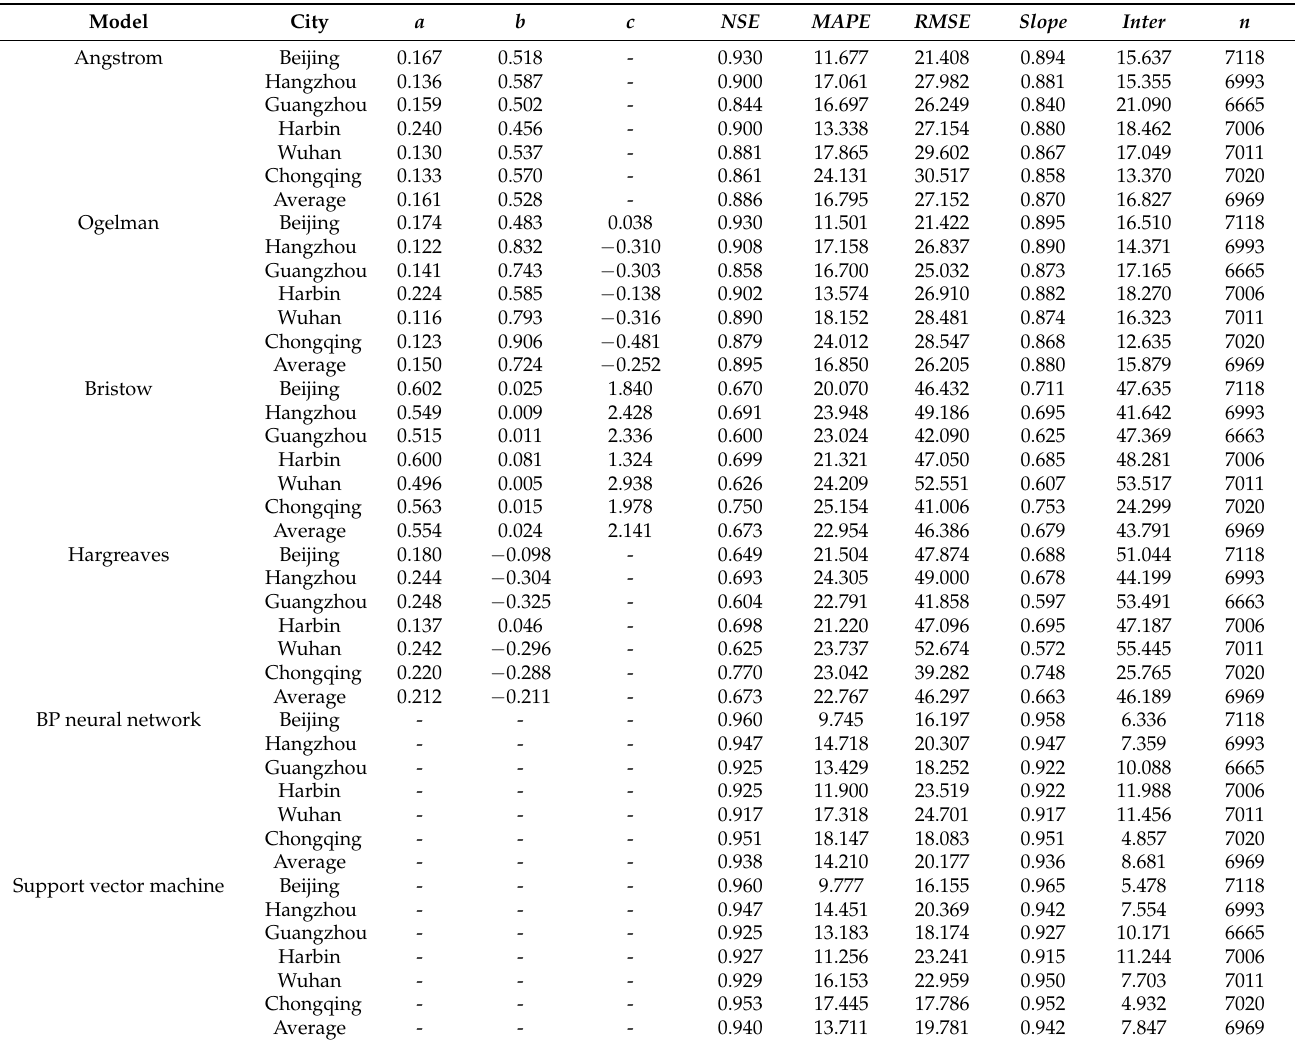
Table 3. Calibration results of the empirical models and machine-learning methods on estimation of the solar